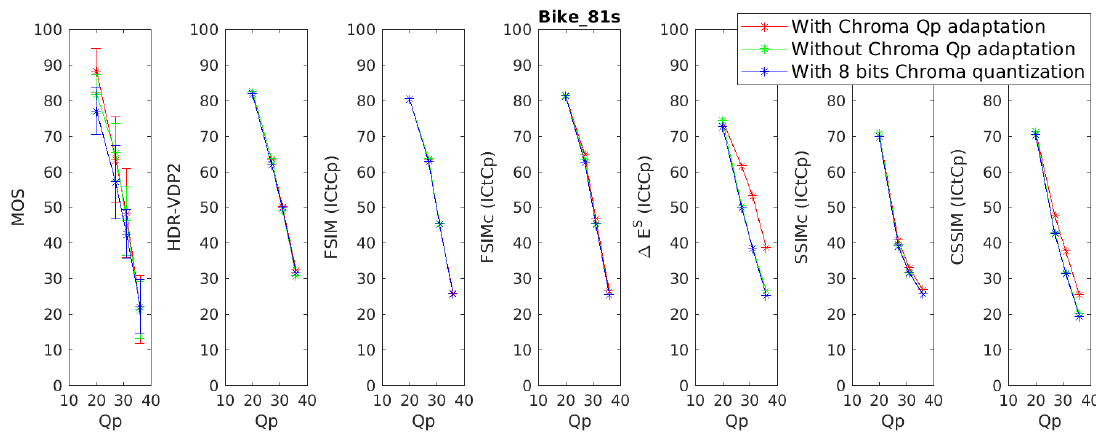
Figure A8. Subjective and objective scores for the image